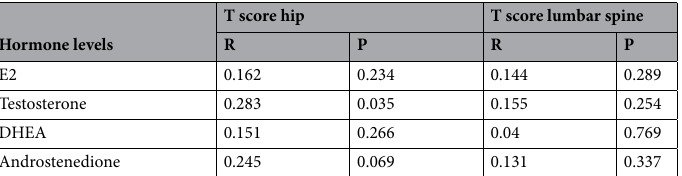
Table 2. Pearson`s correlation coefficients for hormone levels and T score hip and lumbar spine. Variables controlled: age, race, BMI, alcohol, smoking habits, age of menarche, type of menstrual cycles, parity, age of menopause, years since menopause, vaginal estrogen